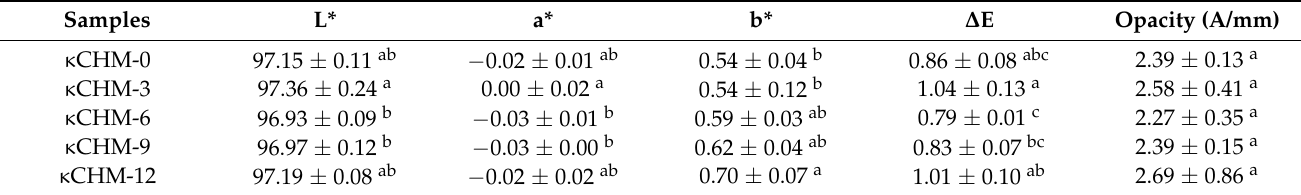
Table 2. Color parameters and opacity of κ CHM